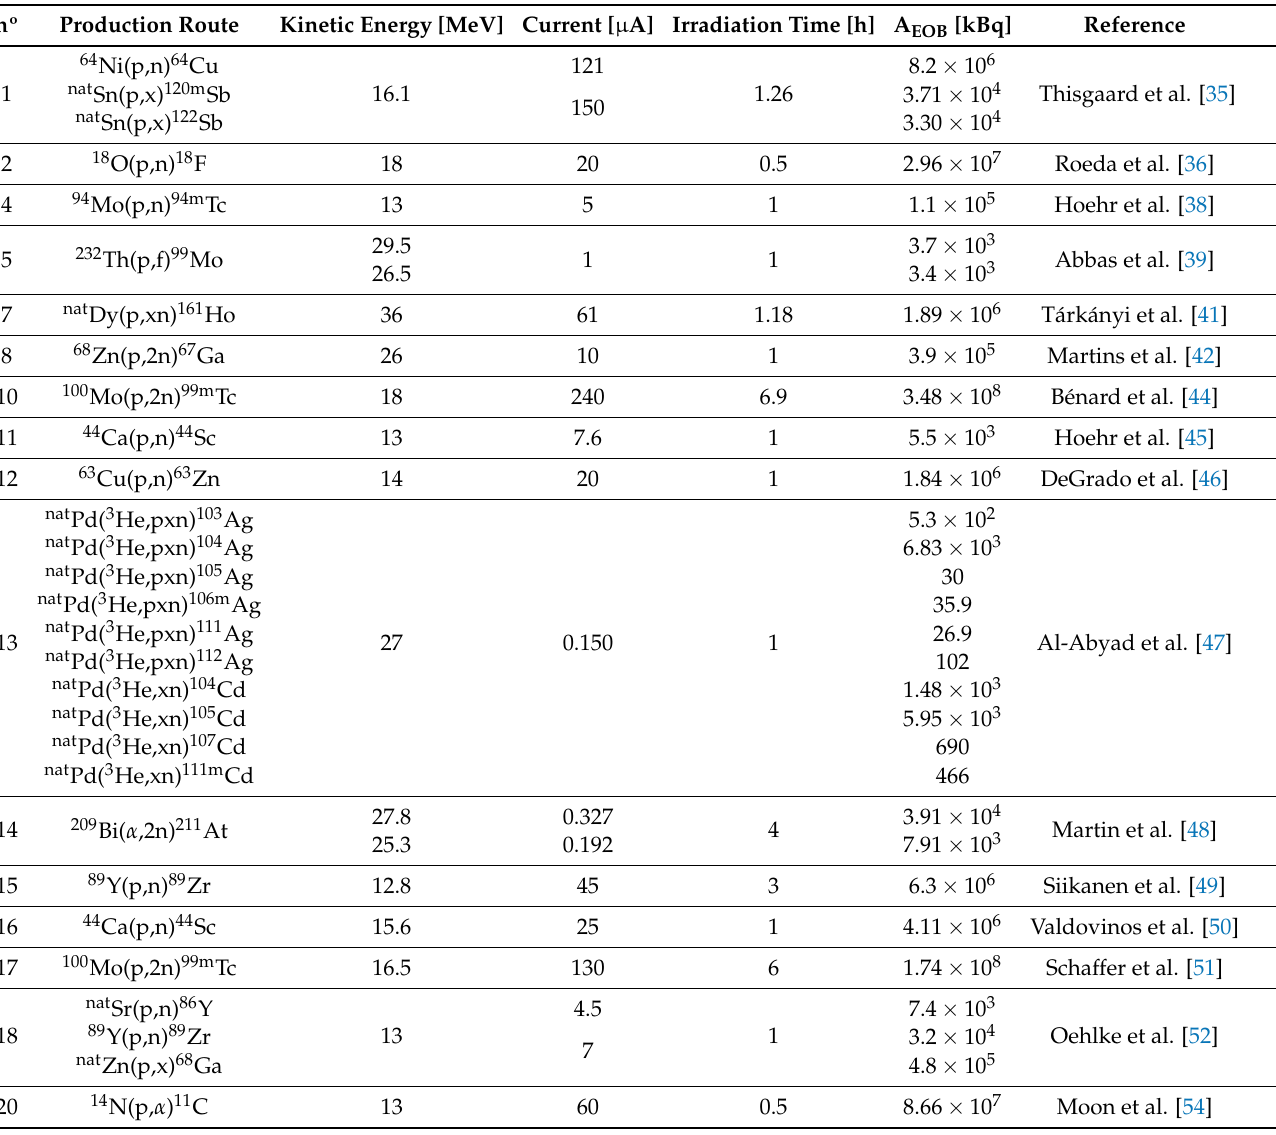
Table A2. Cyclotron produced